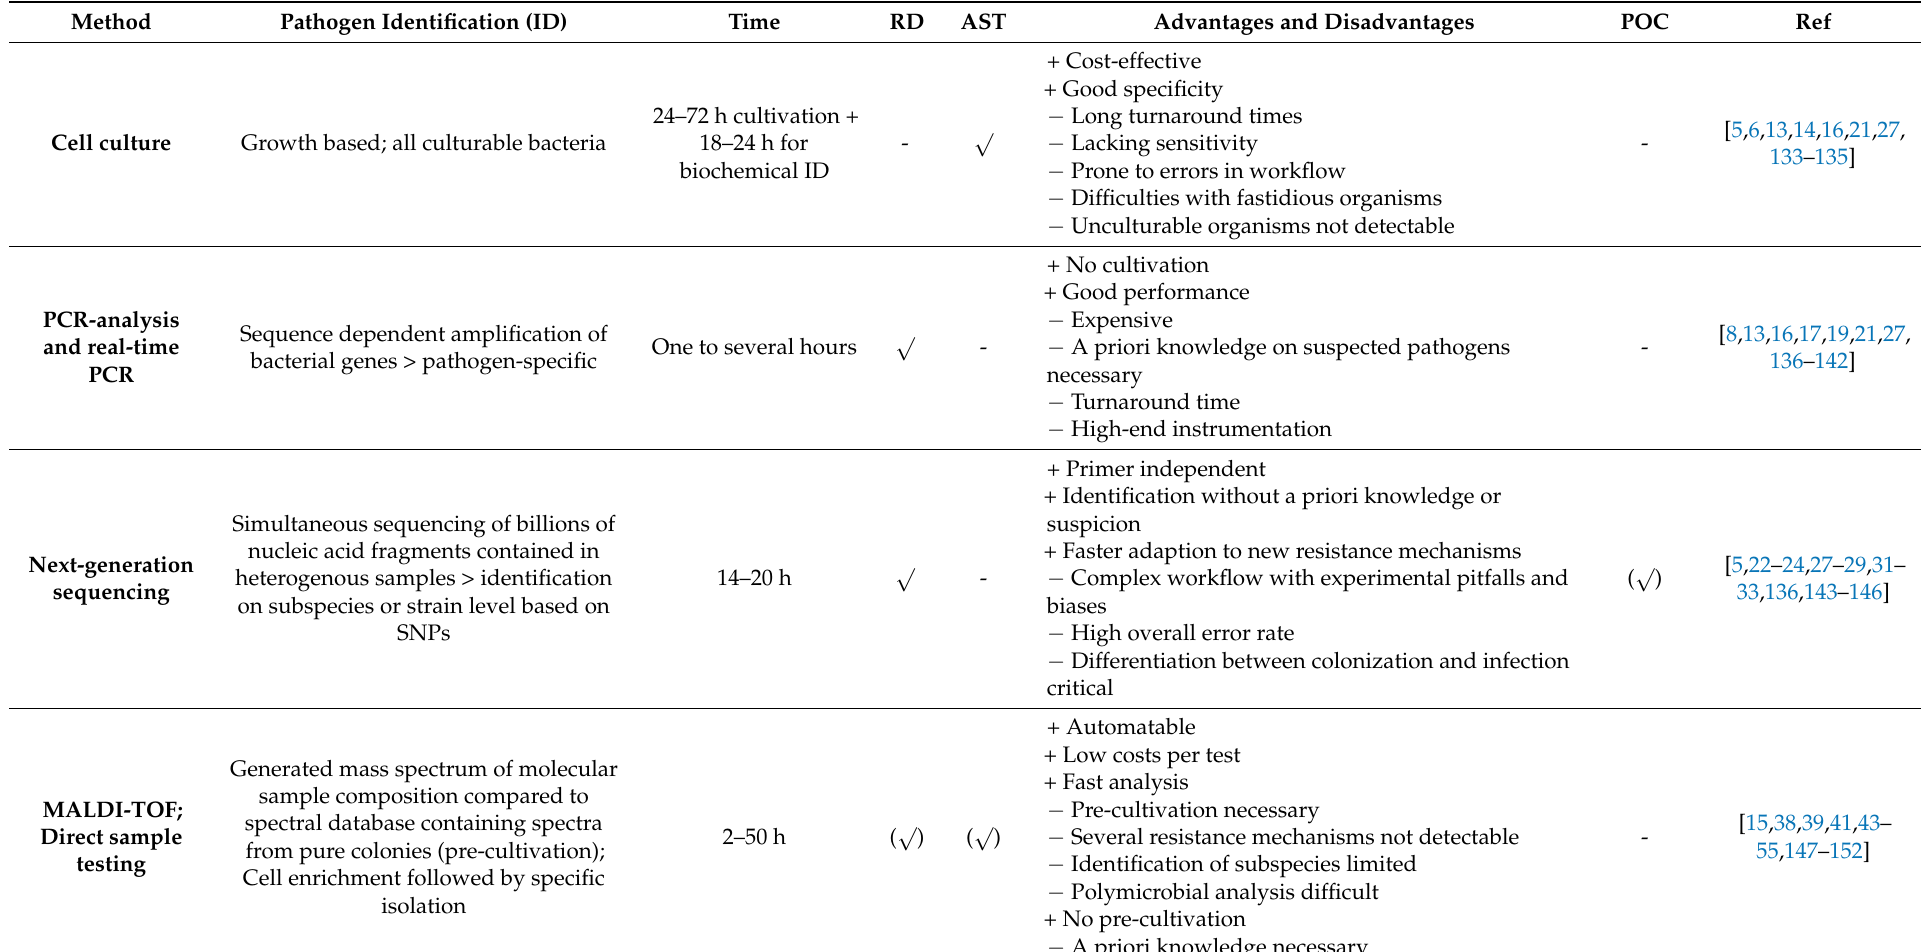
Table 1. Comparison of methods applicable for pathogen detection. (RD: Resistance Determination, AST: Antimicrobial susceptibility testing, POC: Point-of-Care).